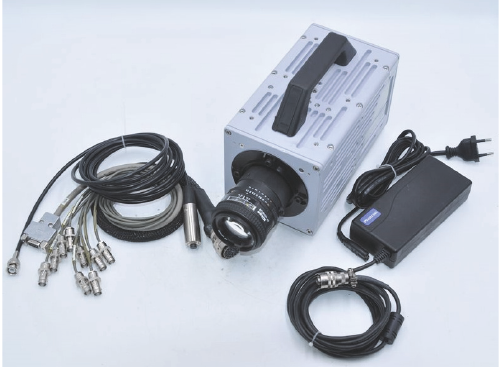
Figure 9: The camera of FASTCAM SA-X29.